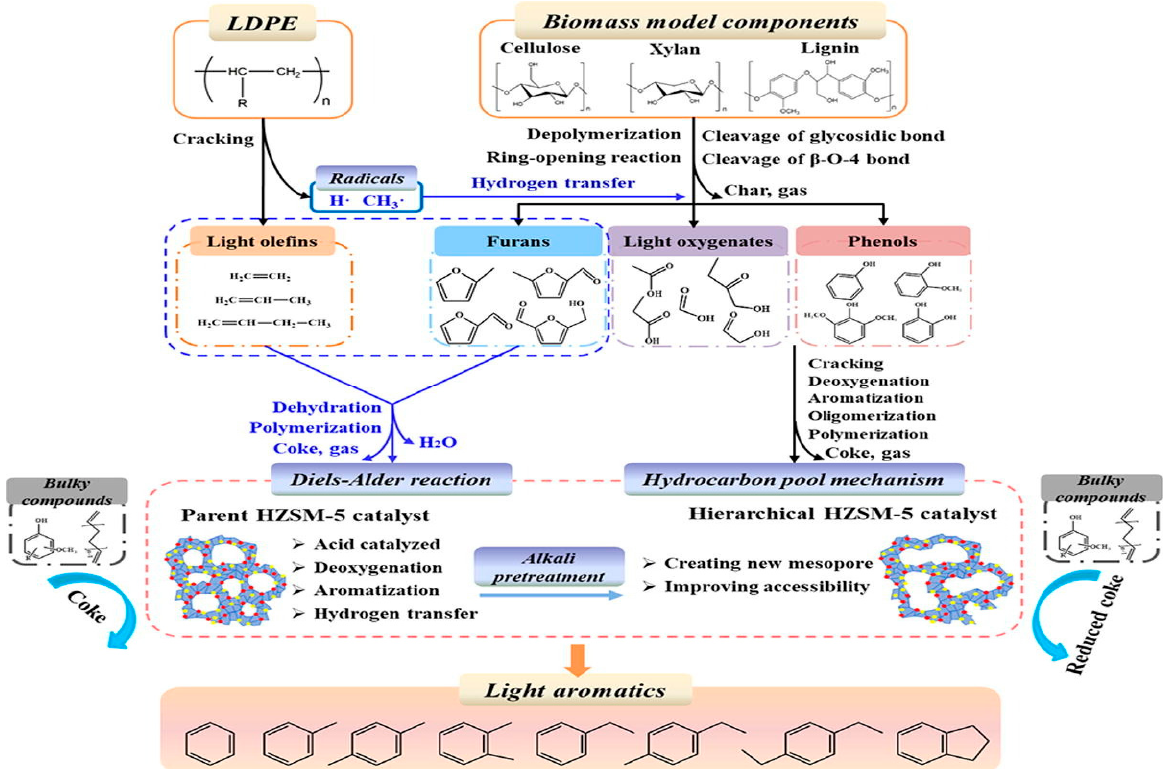
Figure 3. Possible synergistic reaction pathways during co-pyrolysis of biomass components with LDPE over HZSM-5 [31]. Copyright 2022, Elsevier.